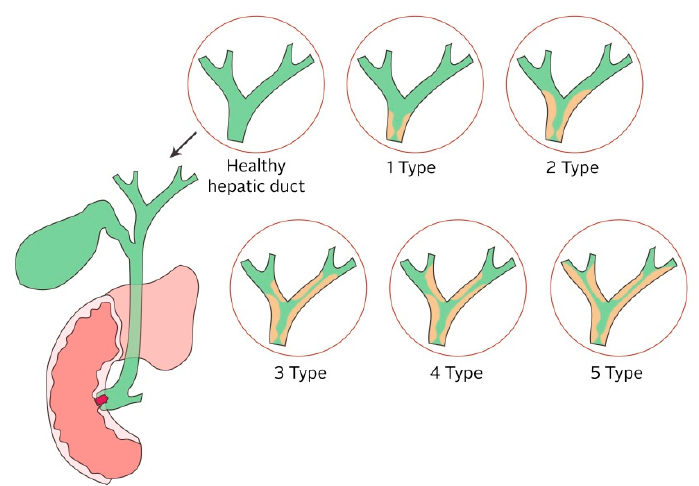
Figure 5. Types of biliary obstruction classified by Bismuth [105]: 1 Type: An obstruction is located further than or equal to 2 cm from the main hepatic confluence, 2 Type: An obstruction is located less than 2 cm from the main hepatic confluence, 3 Type: The ceiling of the biliary confluence is intact, right ductal system communicates, 4 Type: The ceiling of the biliary confluence is intact, left ductal system communicates and 5 Type: The ceiling of the confluence is destroyed, bile ducts are separated.